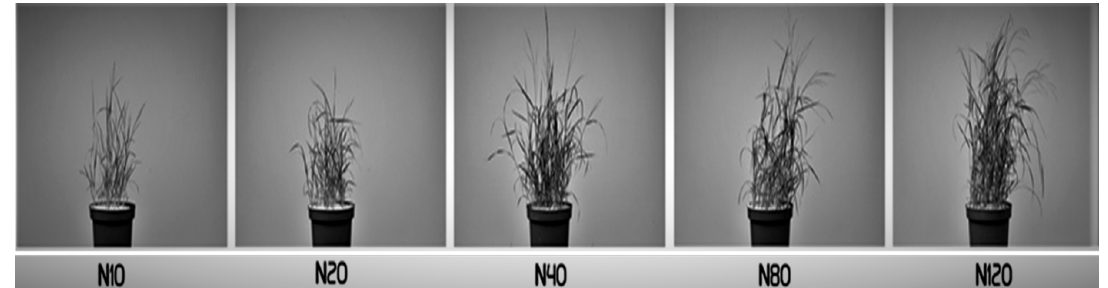
Figure 2. Response of tef leaves to different N fertilizer rates. N10–N120 indicates the concentration of N in irrigation solution (10–120 mg L − 1 ) in increasing order from left to right.